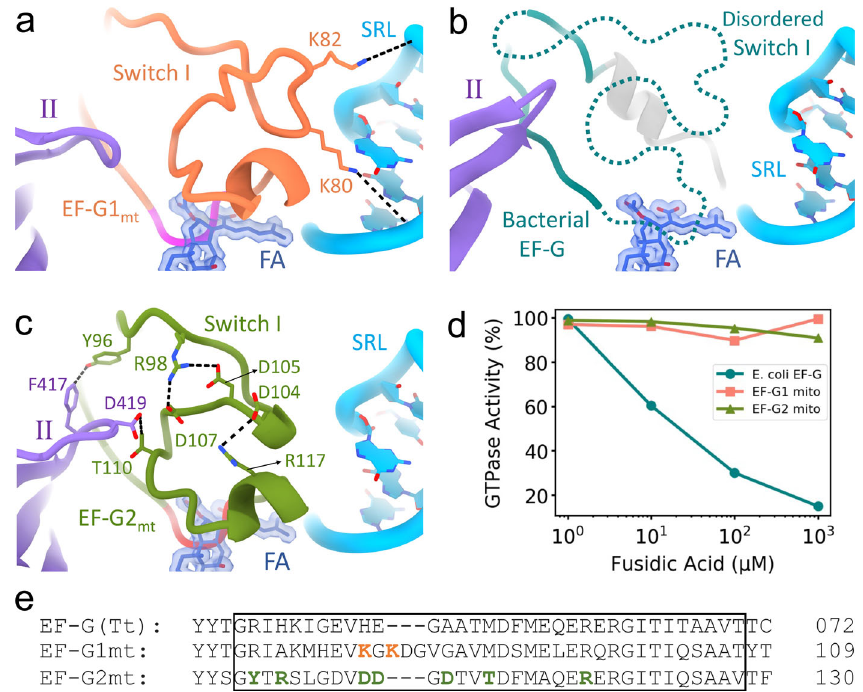
Fig. 7 EF-G1 mt and EF-G2 mt follow diverse mechanisms to render resistance to the antibiotic fusidic acid (FA). a Stabilized Switch I region (salmon) 6 in EF-G1 mt blocks FA (dark blue) from accessing its binding site. The Switch I region sterically overlapping with FA is colored in magenta. Switch I stability is achieved by the presence of two unique lysine residues (K80 and K82) that strongly interact with the phosphates of SRL by forming salt bridges (light blue) 46 . b The absence of these lysine residues in the Switch I region (dark cyan) of bacterial EF-G disorders the Switch I 47 and hence makes it susceptible to FA binding and inhibition. c In EF-G2 mt , the primary aa sequence of switch I (green) is highly altered enabling the formation of three salt bridges within its switch I, thereby stabilizing it. Furthermore, strong interactions are observed between the switch I and domain II (purple) in EF-G2 mt . The Switch I region sterically overlapping with FA is colored in red. d EF-G1 mt (salmon) and EF-G2 mt (green) show strong resistance even at high concentrations of FA, while the bacterial EF-G (dark cyan) is susceptible to FA inhibition even at low concentrations. Each point in the plots represents the average of normalized data from two independent sets of experiments. Raw luminescence values obtained from the GTPase-Glo ™ Assay are shown in Supplementary Table 1. e The aa sequence alignment of the switch I region (boxed) in three EF-Gs. The lysine residues shown in salmon are unique to mammalian EF-G1 mt and confer stability to switch I by interacting with the SRL. Residues shown in green (except R117) are unique to EF-G2 mt and confer stability to switch I by forming salt bridges within the switch I